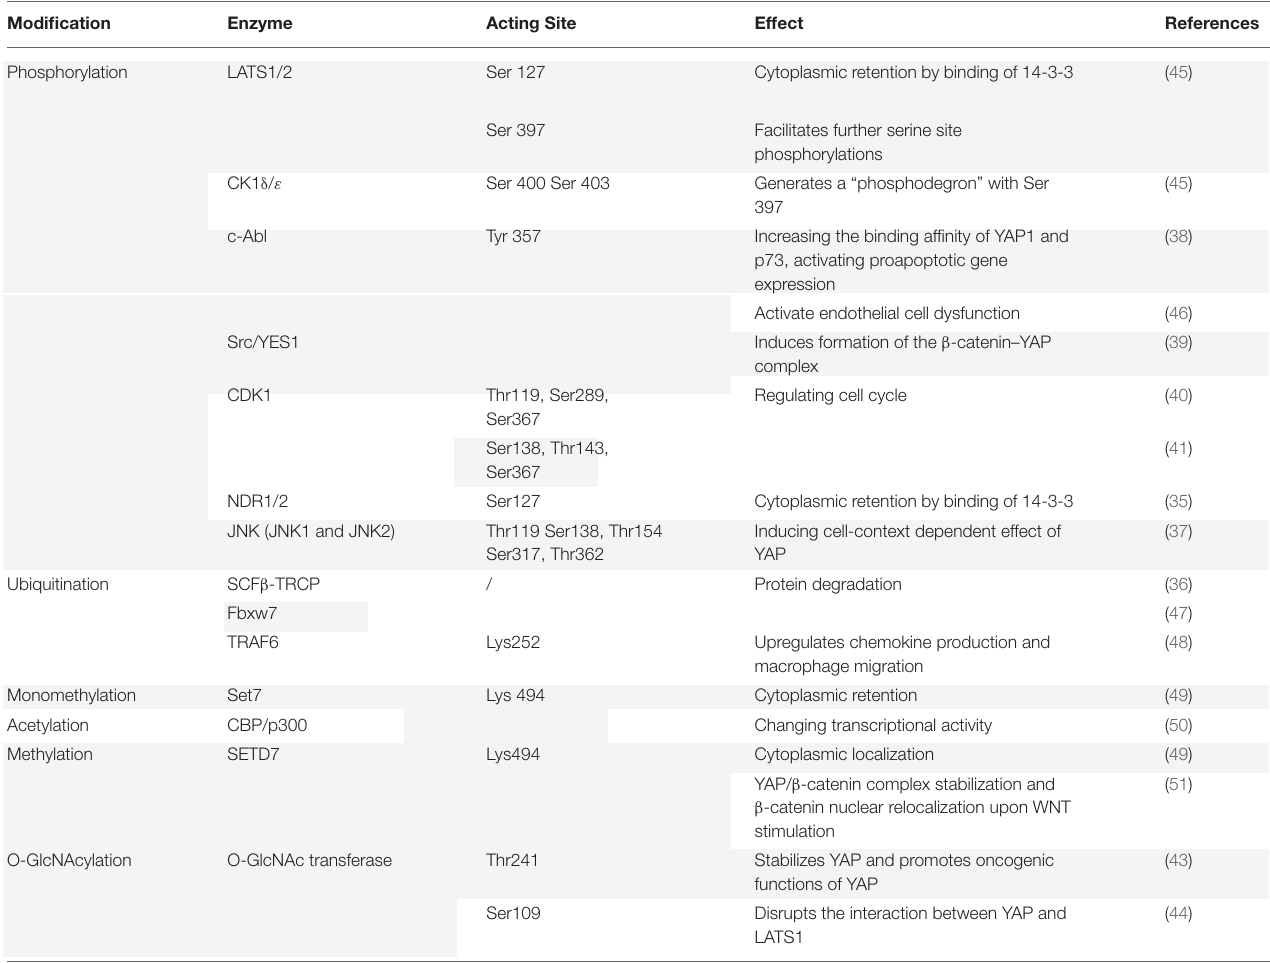
TABLE 1 | Summary of major post-translational modifications (PTM) patterns of